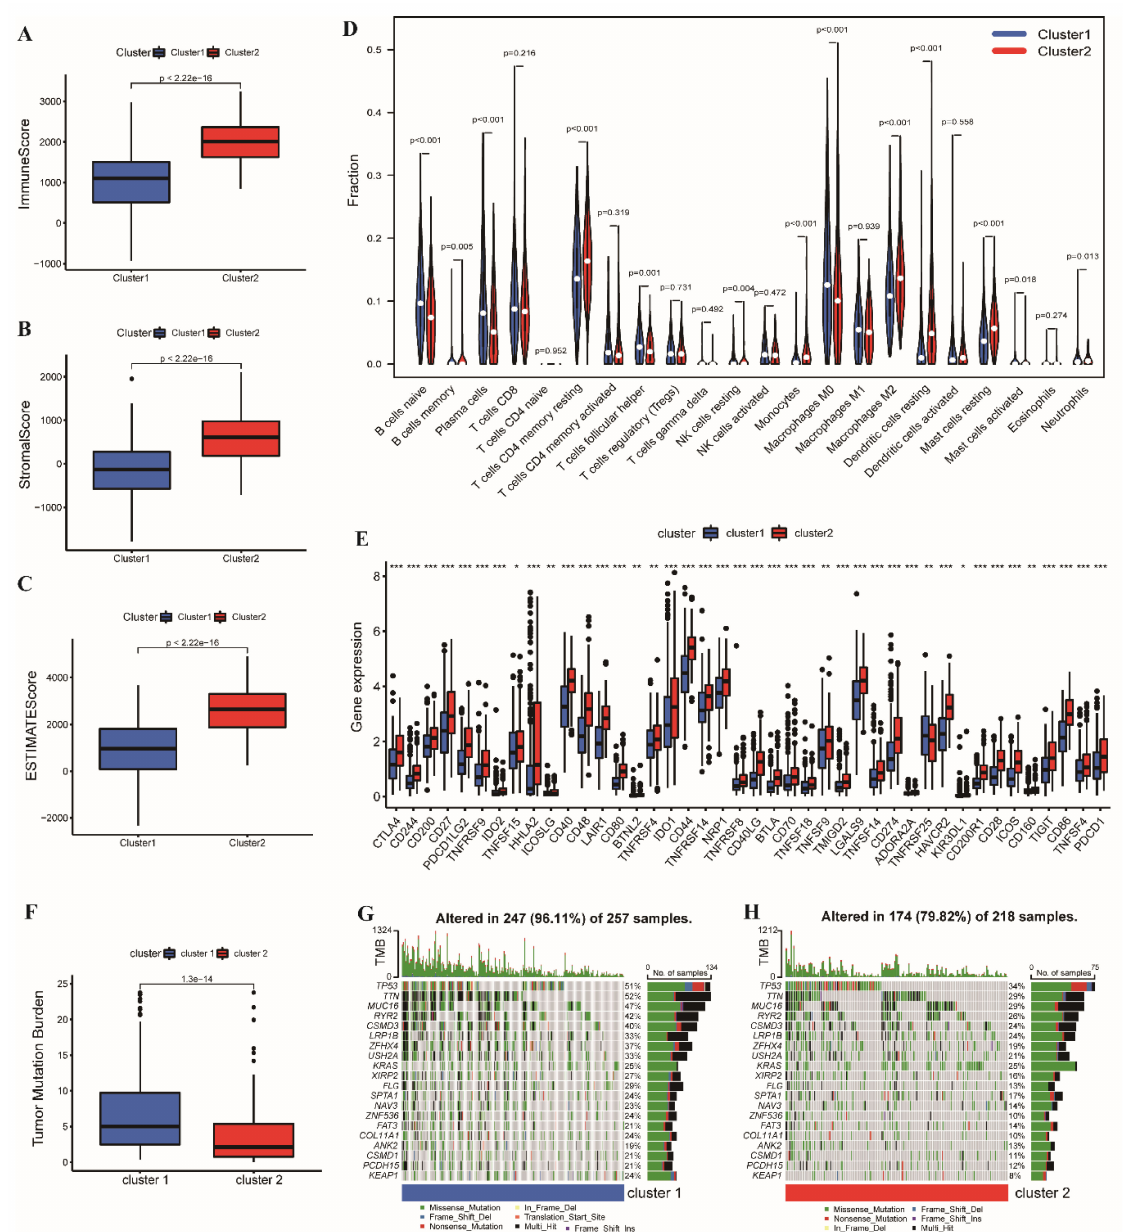
Figure 3. The tumor microenvironment (TME) characteristic of the patients between the two clusters in the TCGA cohort. The distributions of the ( A ) immune score, ( B ) stromal score, and ( C ) ESTIMATE score between the two clusters. ( D ) The fraction of each infiltrating immunocyte in Clusters 1 and 2 by CIBERSORT. ( E ) The boxplot of the 42 differentially expressed immune checkpoint inhibitor (ICI)-related genes in the two clusters. ( F )The boxplot of tumor mutation burden (TMB) of the two clusters. ( G , H ) The waterfall plots of the 20 most frequently mutated genes in the two clusters. (2.22e − 16 = 2.22 × 10 − 16 ; * p < 0.05; ** p < 0.01; *** p <